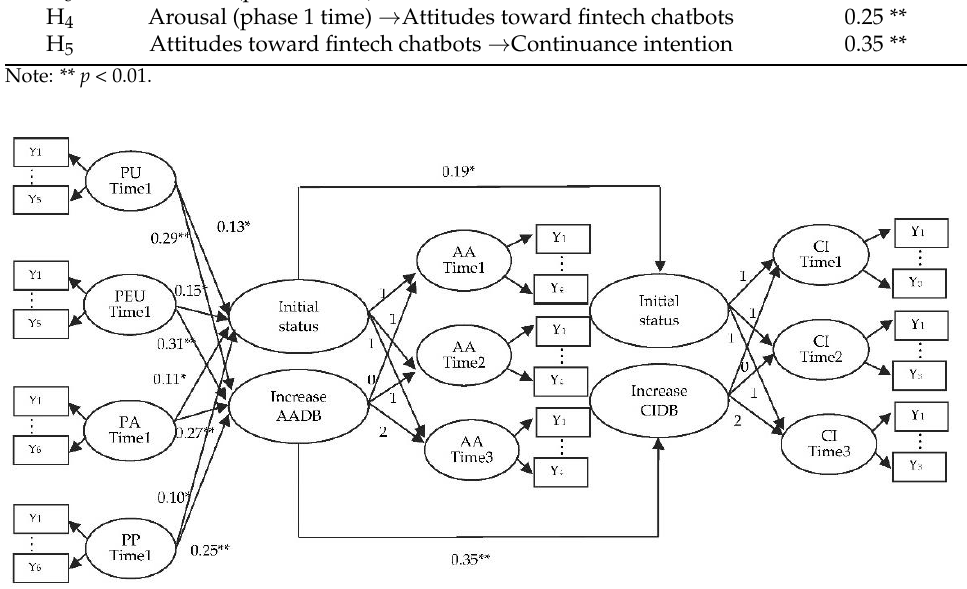
Figure 2. The LGCM. Note: PU = Perceived Usefulness; PEU= Perceived Ease of Use; PA = Perceived Arousal; PP = Perceived Pleasure; AA = Attitudes toward Fintech Chatbots; CI = Continuance Intention; AADB = Attitudes toward Fintech Chatbots development behavior; CIDB = Continuance Intention development behavior. Yn = Measurement items. Exogenous Variables: PU, PEU, PA, and PP; Endogenous Variables: AADB, and CIDB. * p < 0.05; ** p < 0.01. Improved growth in attitudes toward fintech chatbots (β = 0.35, p < 0.01) significantly